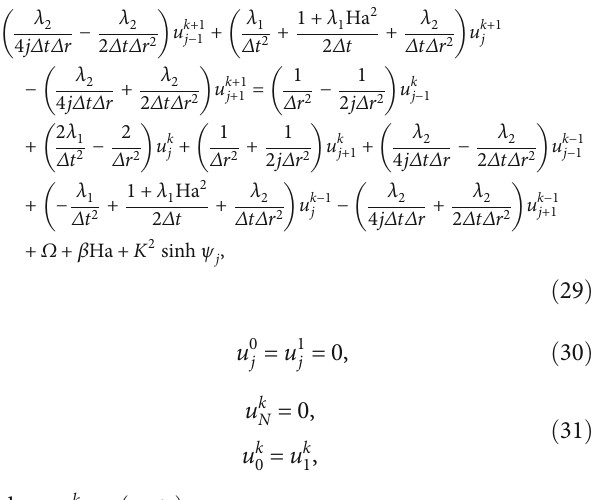
= 0 : 7, λ = 0 : 08, β = 1, Ω = 1, t = 1 Þ 1 2